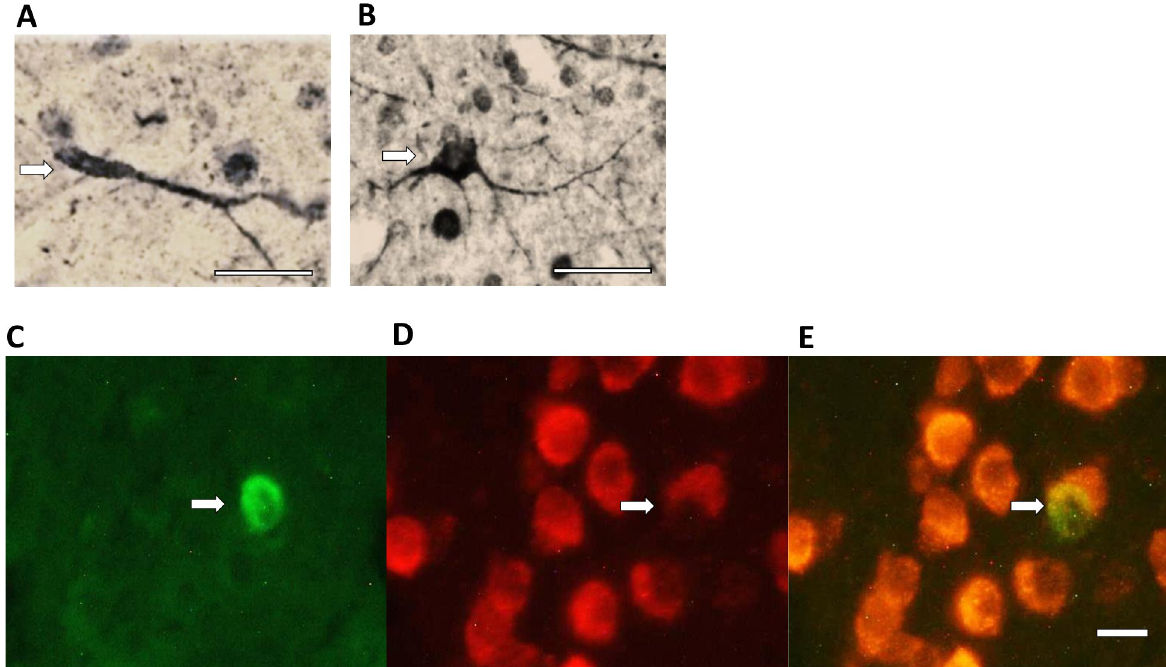
Fig 2. Photomicrographs of doublecortin-positive neurons in HVC. A. Fusiform, approximately 1–2 weeks old as indicated by its thin, elongated soma and unipolarity and B. Multipolar, approximately 2–3 weeks old as indicated by large, round soma and multiple processes (cell age estimates follow Balthazart, et al., 2008) [59]. C. Fluorescent markers used to identify 28–30 d old neurons in HVC, BrdU + nucleus visualized with FITC filter. D. Hu + neurons seen under rhodamine filter. E. BrdU + /Hu + neuron showing colocalization of the two markers (rhodamine/FITC filter) in the same field of view. Scale bars A, B = 25 μ m; C, D = 10 μ m. Higher positive values indicate more new neurons in the left hemisphere relative to the right, an outcome of arbitrarily subtracting right from left in the equation: